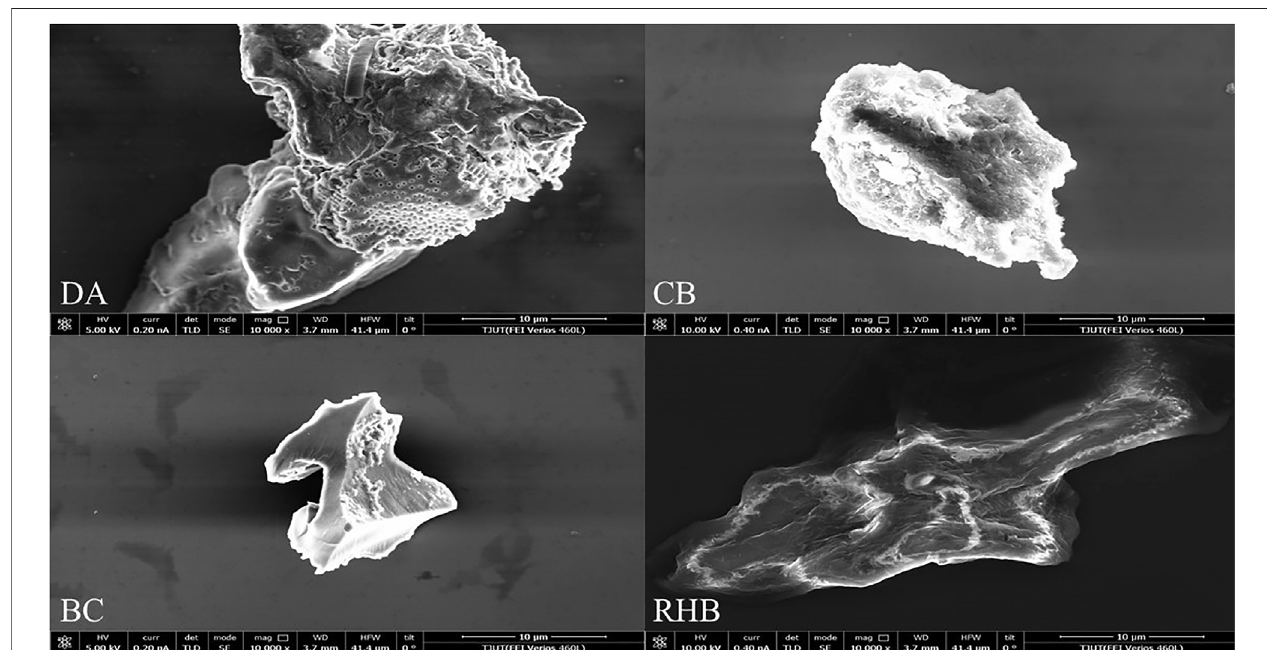
FIGURE 1 | FEI-SEM images of the four adsorbent materials.